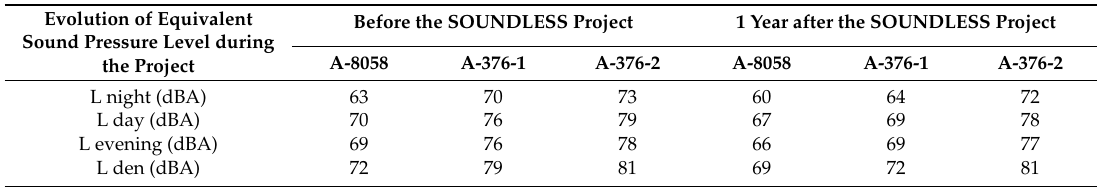
Table 8. Equivalent sound pressure level values one year after the asphalt